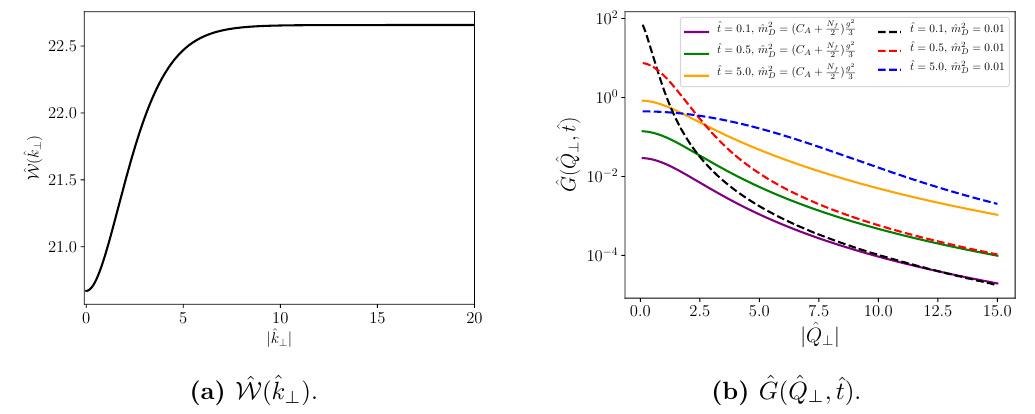
Figure 1. Numerical results of ^